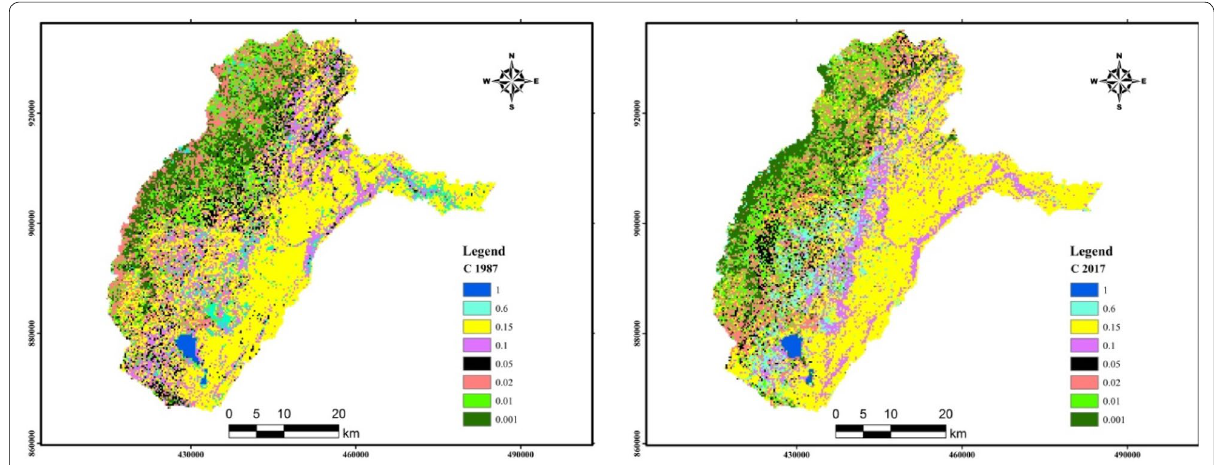
Fig. 11 Land cover factor map of Meki watershed in 1987 and 2017